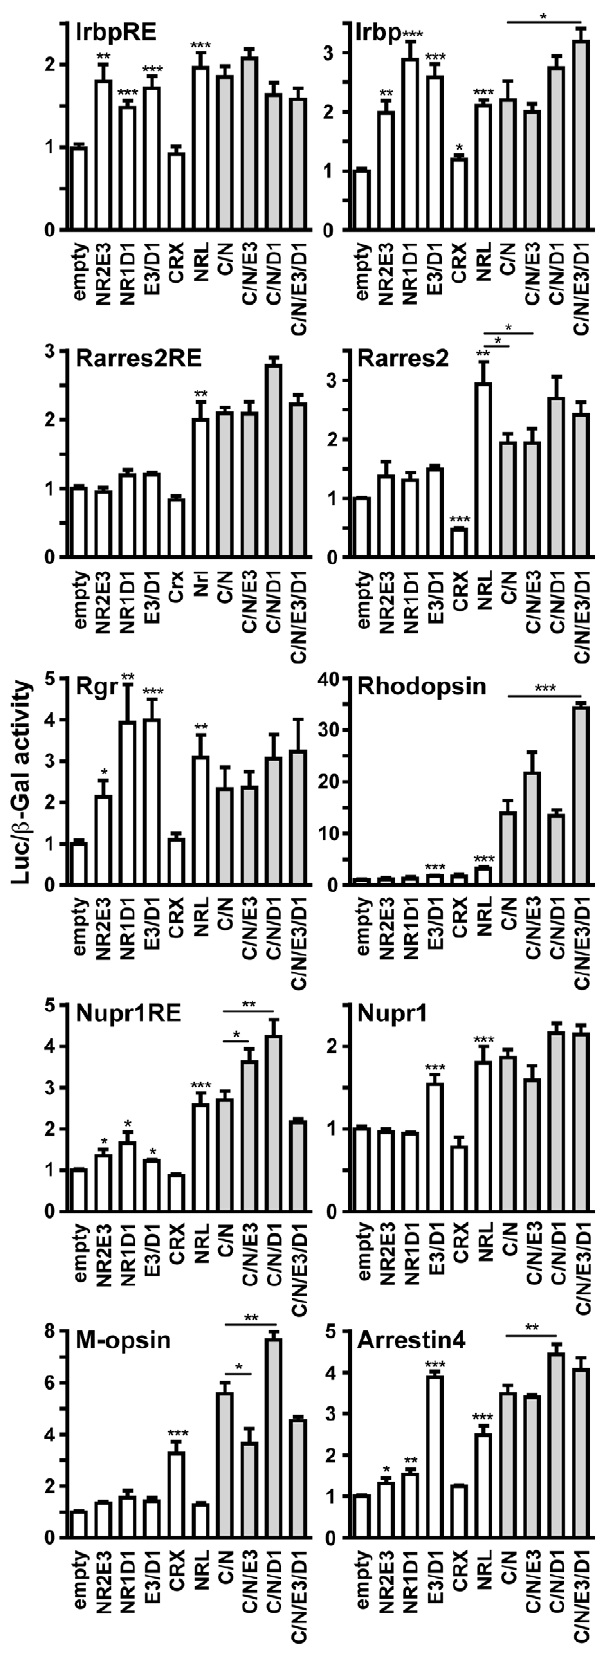
Figure 7. Transactivation assays on putative promoter and enhancer sequences. HEK293T cells were transiently transfected with luciferase reporter constructs containing proximal promoter or enhancer (response elements denoted as RE) regions of Rgr, Rarres2, Nupr1, Irbp, Arrestin4 (previously called cone arrestin 3 ), M-opsin , and Rhodopsin (see Material and Methods). Transfection experiments were performed in 12-well plates, with 500 ng of luciferase reporter plasmids and 30 ng of expression vectors for NR2E3 (E3), NR1D1 (D1), CRX (C) and NRL (N) added per well. To obtain equal amounts of transfected DNA, appropriate amounts of the pcDNA3.1 plasmid (empty) were added. Luciferase activity was normalized to beta-galactosidase activity. Results are expressed as means 6 SEM (n=12–16). For samples containing both CRX and NRL, columns are colored in grey. Statistical significance of a two-tailed unpaired t-test are shown as: *: p , 0.05; **: p , 0.01; ***: p , 0.001. If not indicated otherwise with horizontal bars, statistical significance is relative to the empty control sample. For clarity of the histograms, the significant induction of all luciferase reporter constructs in presence of both CRX and NRL is not